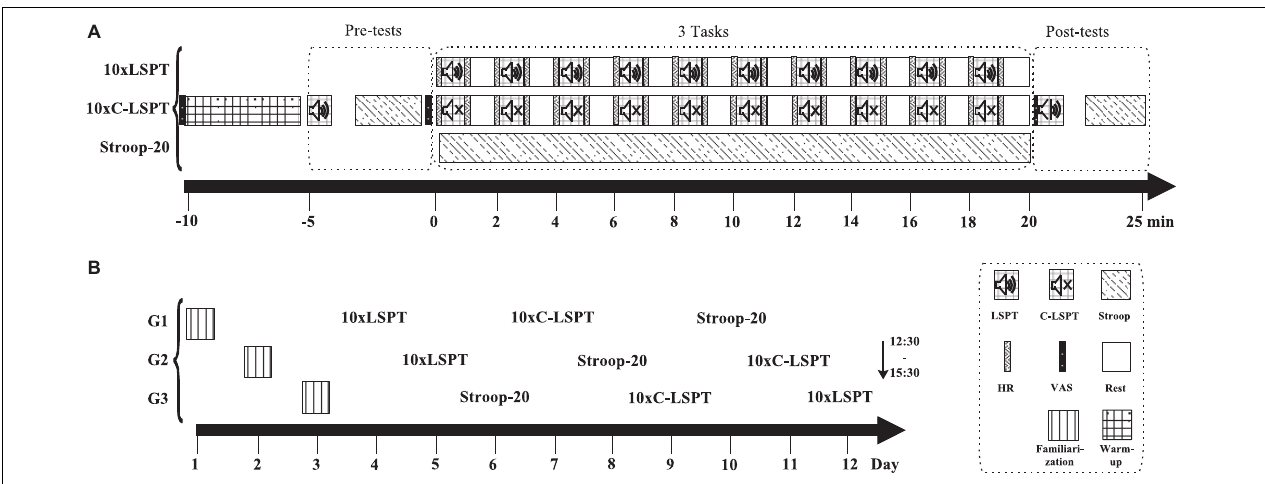
FIGURE 1 | Timelines of study procedures. (A) Timeline of test sessions; (B) timeline of study design; LSPT, Loughborough Soccer Passing Test; 10xLSPT, 10 repeats of Loughborough Soccer Passing Test; C-LSPT, modified Loughborough Soccer Passing Test in a clockwise passing order; 10xC-LSPT, 10 repeats of modified Loughborough Soccer Passing Test in a clockwise passing order; Stroop, Stroop task; Stroop-20, 20-min Stroop task; VAS, visual analog scale; HR, heart rate; G, group of